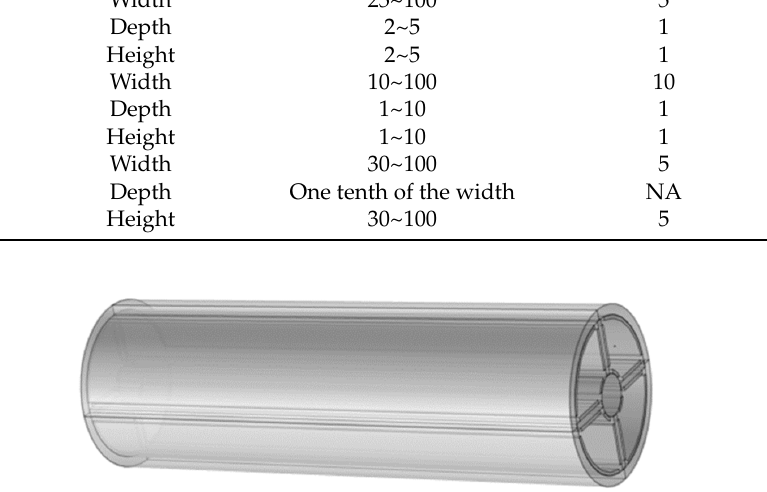
Figure 10. Simulation model of capacitive sensor.